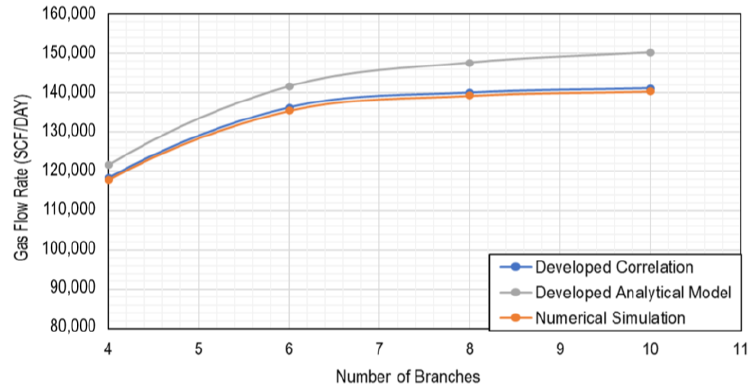
Figure 12. The effect of the number of branches on cumulative production.